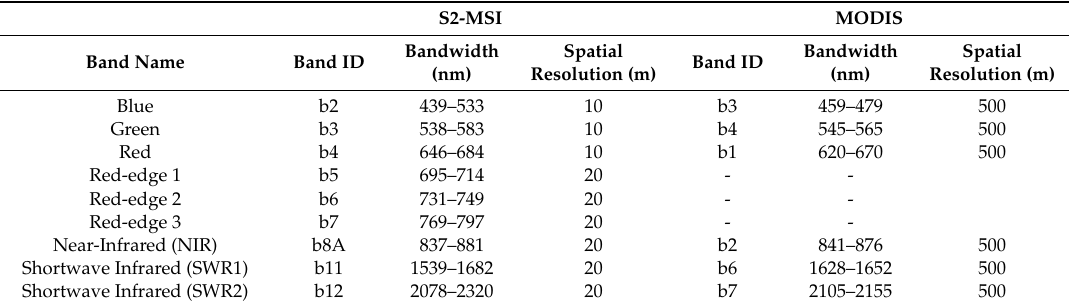
Table 1. Sentinel-2 Multispectral Imager (S2-MSI) bands used by SL2P and the corresponding Moderate Resolution Imaging Spectroradiometer (MODIS)